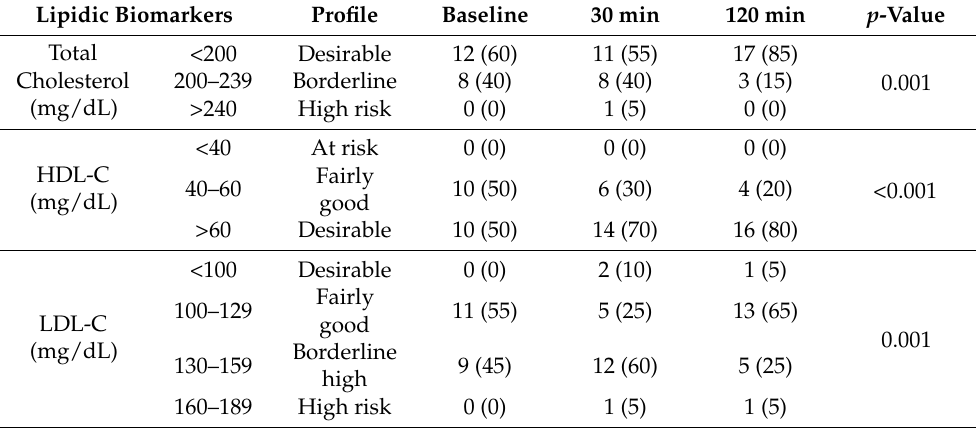
Table 2. Lipoprotein distribution profile in heavy cannabis users. Changes in cholesterol concentra- tion were evident for HDL at 30 and 120 min, for LDL at 30 min, and for total cholesterol at 120 min. Lipid profile results were interpreted according to NCEP ATP II. Data in N